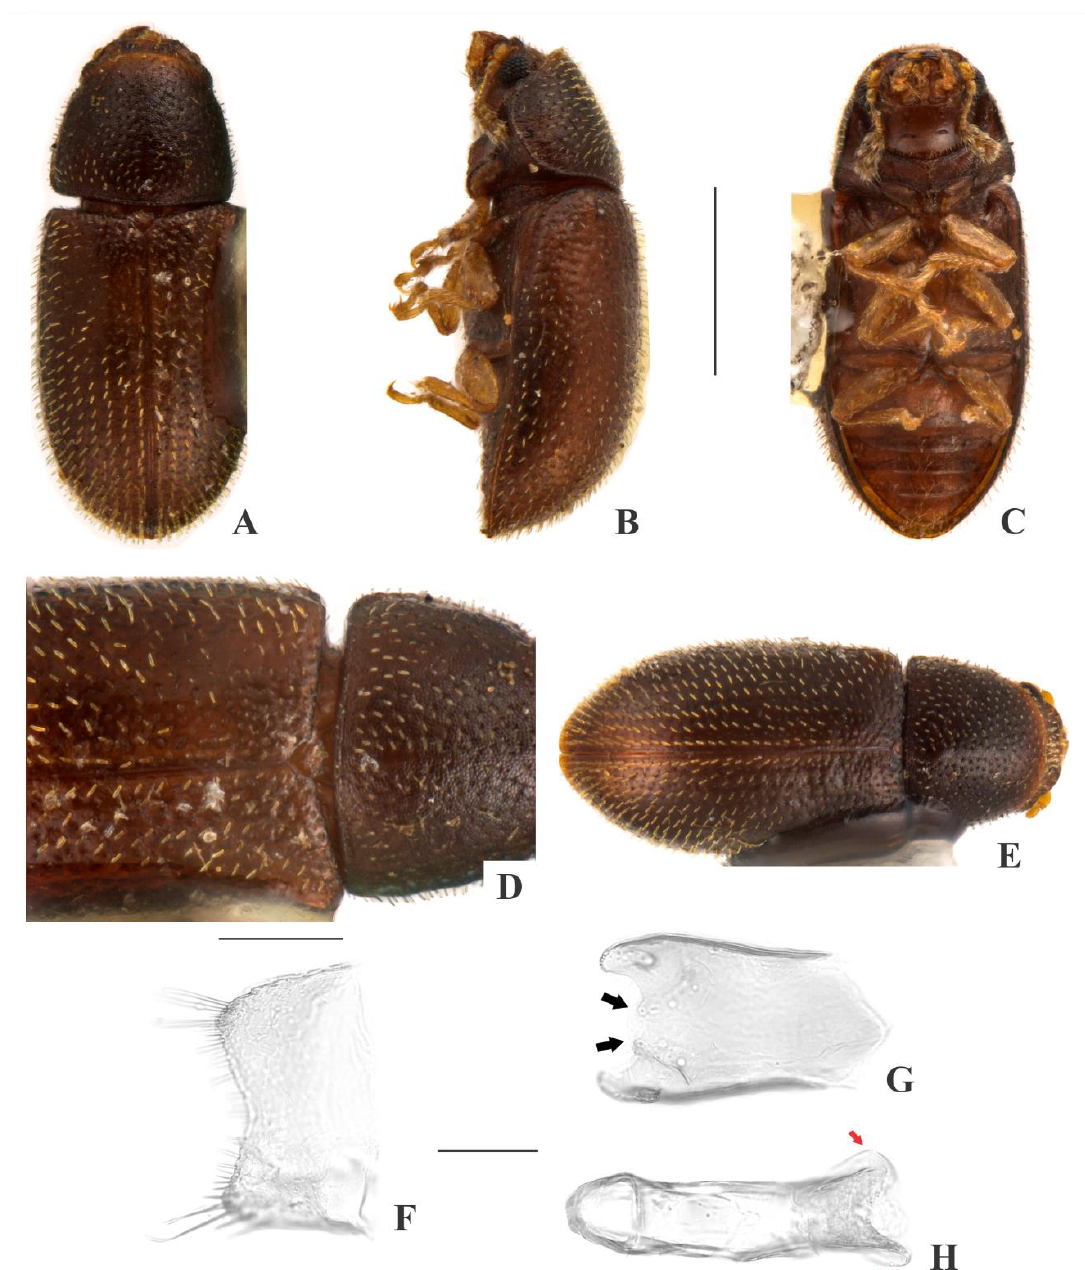
Figure 5. Cis lacinipennis sp. n. , male holotype ( A – D ), female paratype ( E ), aedeagus of paratype from type locality ( F – H ): ( A ) Dorsal view. ( B ) Lateral view. ( C ) Ventral view. ( D ) Scutellar shield and part of the pronotum and elytra. ( F ) Sternite VIII. ( G ) Tegmen, note small tubercles at apex (black arrows). ( H ) Penis, note flaps at anterior portion (red arrows). Scale bars: 0.5 mm ( A – C , E ), 0.2 mm ( D ), 0.05 mm ( F – H ).